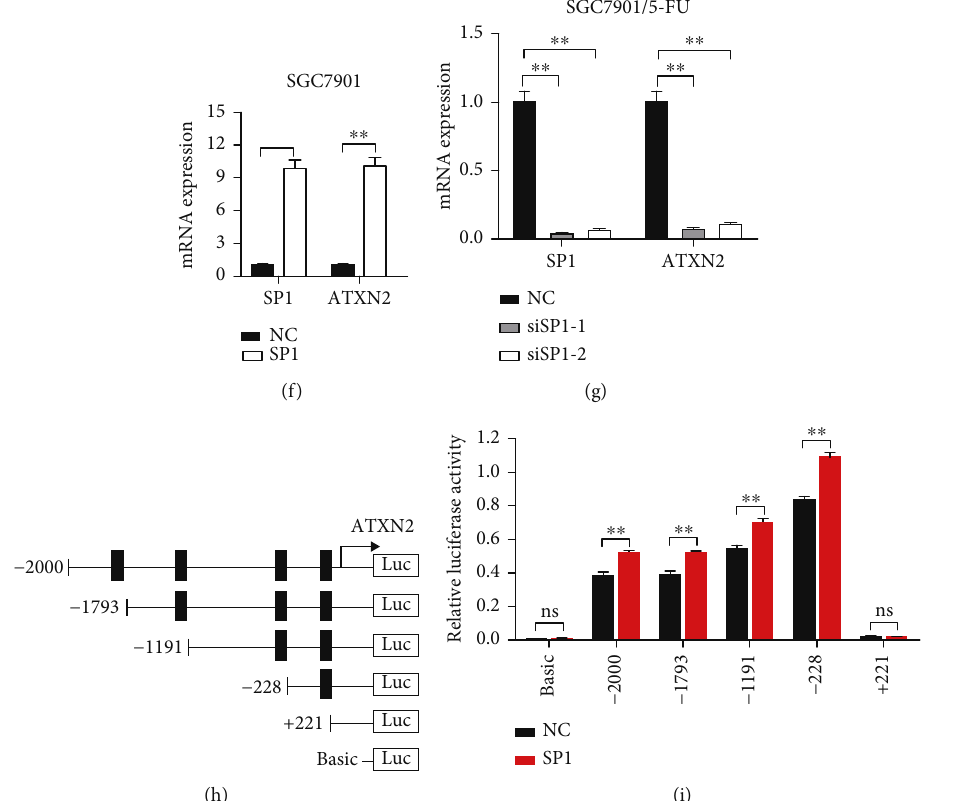
Figure 5: SP1 regulated the expression of ATXN2. (a) Transcription factors were identi fi ed using the JASPAR and PROMO databases. (b, c) The correlation between ATXN2 and SP1 and GATA3 and TCF4 in the TCIA database (b) and GEPIA database (c). (d) The expression of SP1 in the GEPIA database. (e) The correlation between SP1 and GC prognosis. (f, g) SP1 and ATXN2 expression in SGC7901 cells (f) and SGC7901/5-FU cells (g). (h, i) Dual luciferase reporter assay analysis of SP1 binding to the ATXN2 promoter. ∗∗ P < 0 : 01